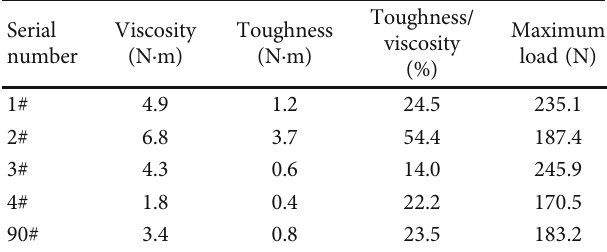
Table 3: Toughness test results of tire rubber powder-modi fi ed